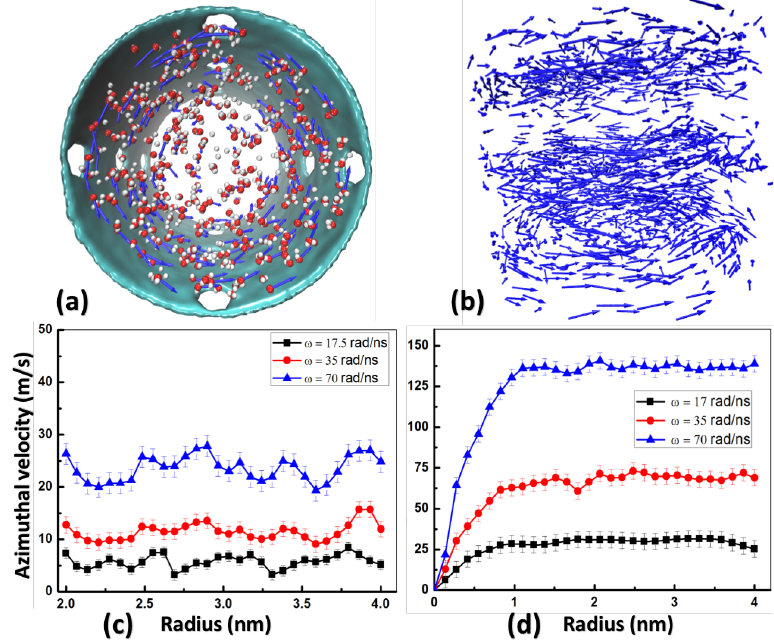
Figure 5. ( a ) Top-view of rotating water molecules (Oxygen in red and Hydrogen in white) with velocity vector (blue arrows) plotted on Oxygen. ( b ) 3D plot of velocity field of water molecules. Only velocity vectors (blue arrows) are shown. Azimuthal velocity v θ along radial direction of Model I ( c ) and Model II ( d ) under different angular